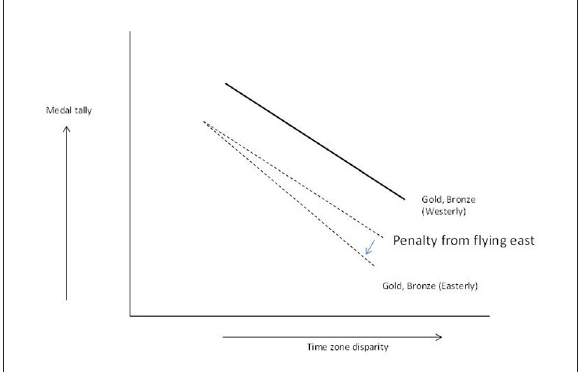
FIGURE1 Gold and Bronze medal pattern.